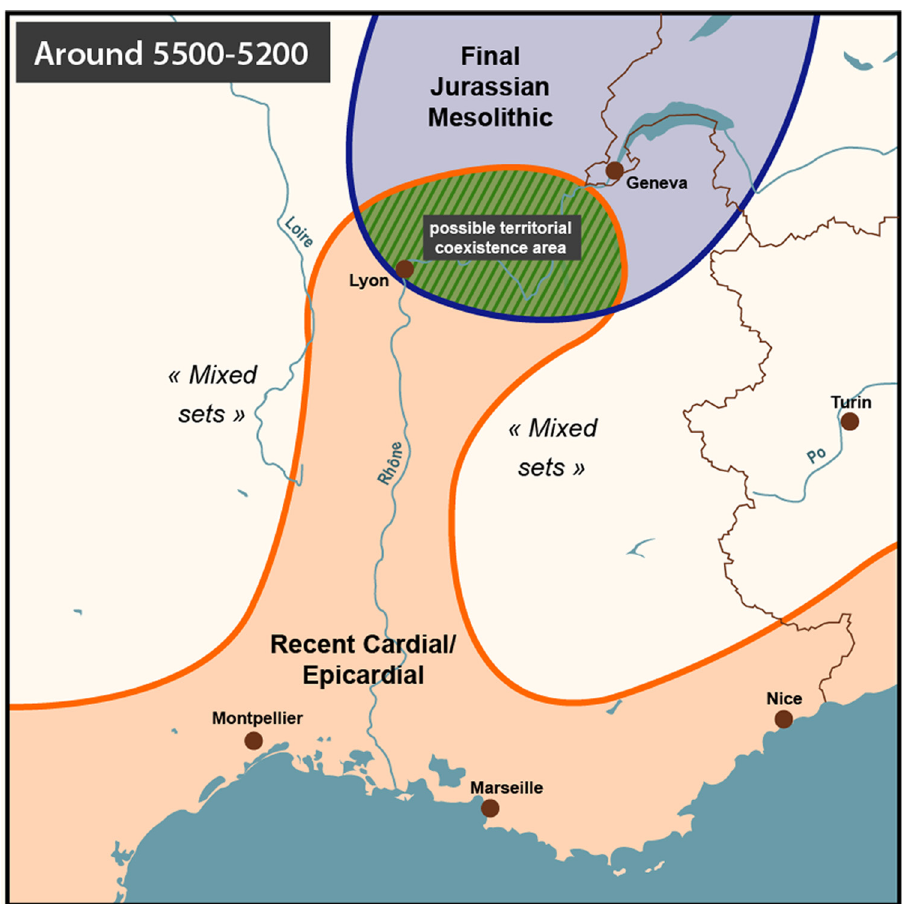
Figure 2: Hypothesis of chronocultural evolution in the Rhone Basin between 5500 and 5200 cal. BC ( modi fi ed from Perrin, 2003b )